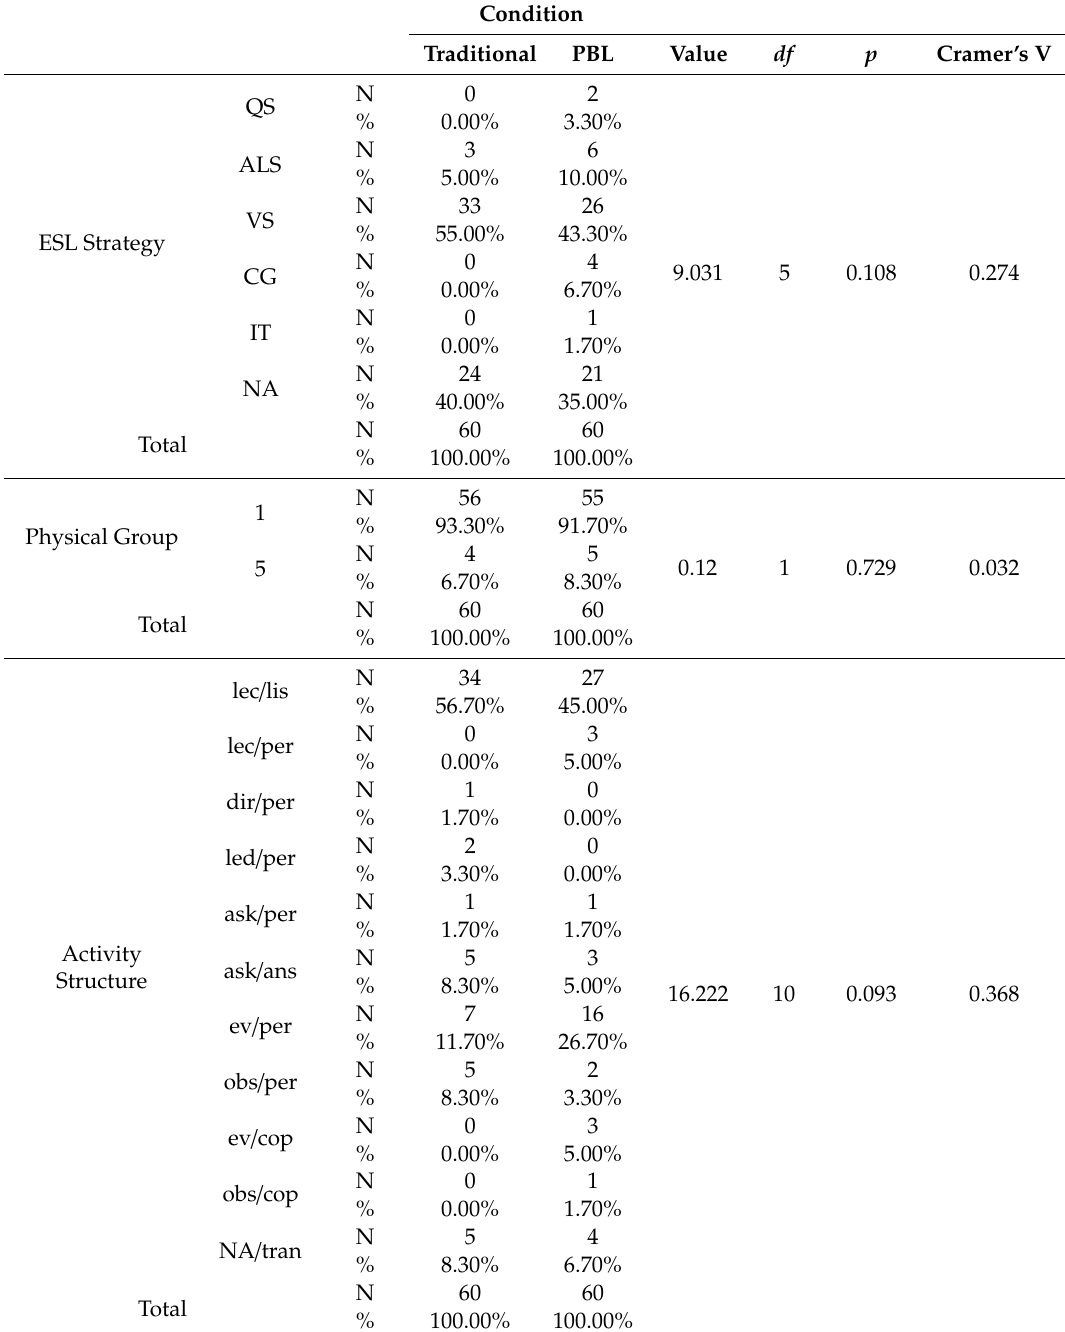
Table 1. Chi-square statistics of instructor’s pedagogical behaviors in the warm-up and vocabulary module between the problem-based learning (PBL) and traditional